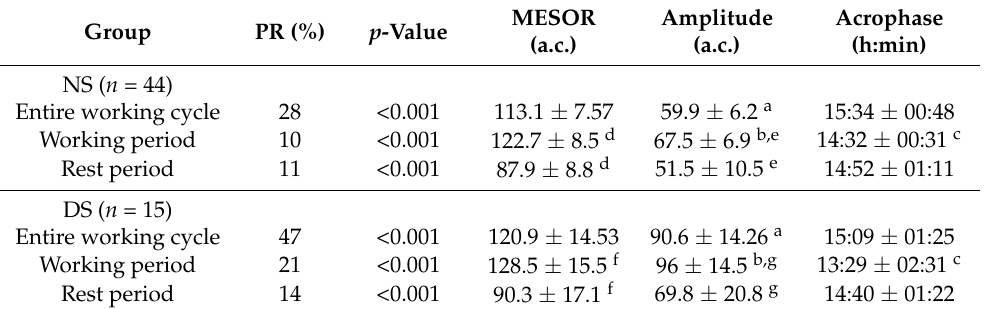
Table 1. Population mean cosinor analysis in night shift and day shift nurses during the entire working cycle, the working period and the rest